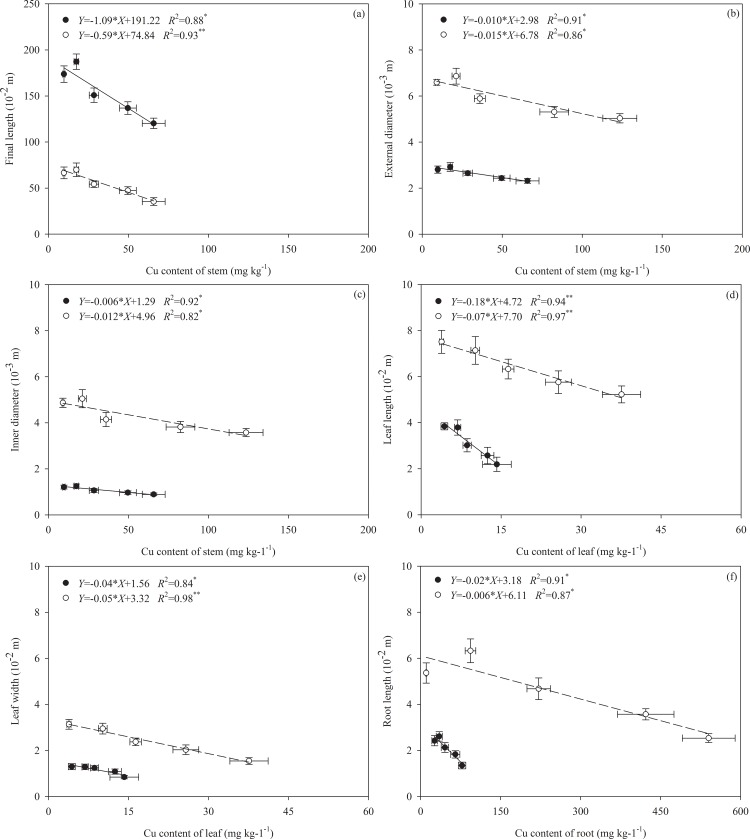
Relationships among the Cu content of the stem and the final length (a), external diameter (b), and inner diameter (c); Cu content of the leaf and the leaf length (d) and leaf width (e); and Cu content of the root and the root length (f) of Alternanthera philoxeroides in terrestrial habitats (black circles; unbroken lines) and aquatic habitats (white circles; broken lines). Regression equations, coefficient of determination (R2) and significance level (*, P < 0.05, **, P < 0.01) are shown. Values are indicated as the means ± SD.